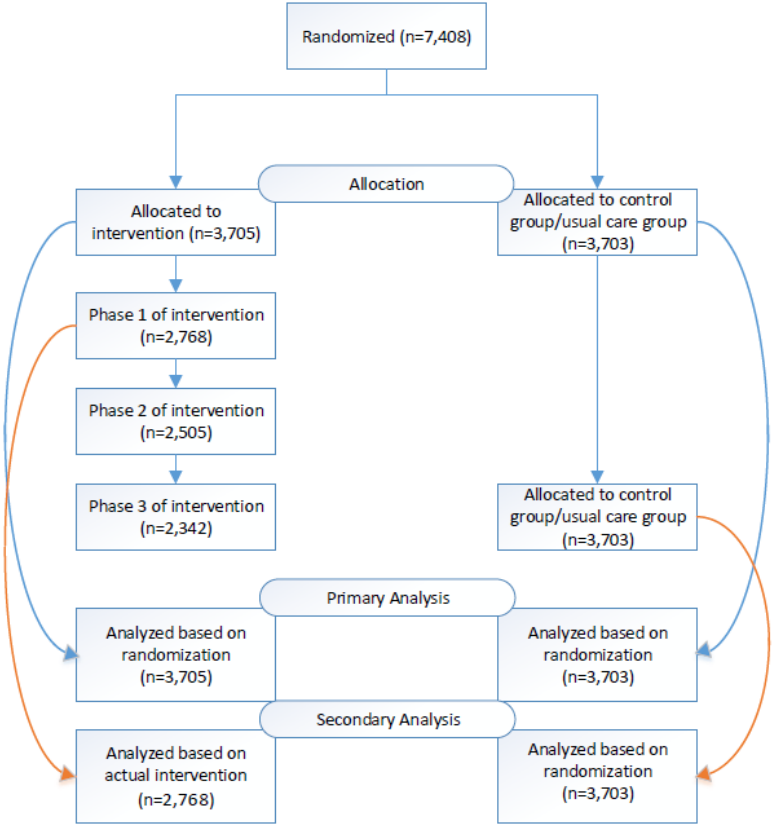
Figure 1. Consort flow diagram-participant randomization, intervention, and analysis.